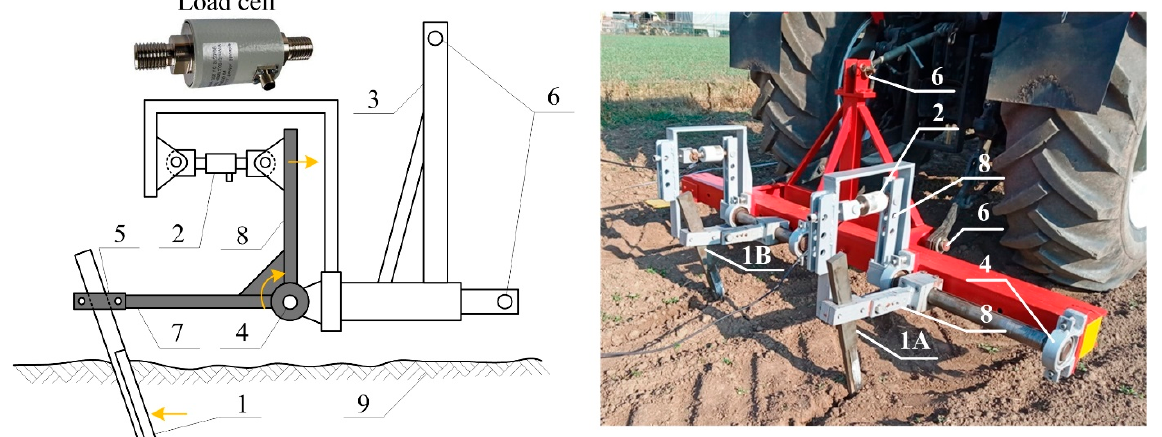
Figure 2. Scheme and design of SRSF (yellow arrows mean sensor parts motion during operation): 1—cutting blade; 1A—cutting blade within the tire track; 1B—cutting blade outside the tire track; 2—load cell; 3—frame; 4—pivot; 5—cutting blade fastening; 6—connection to the three ‐ point